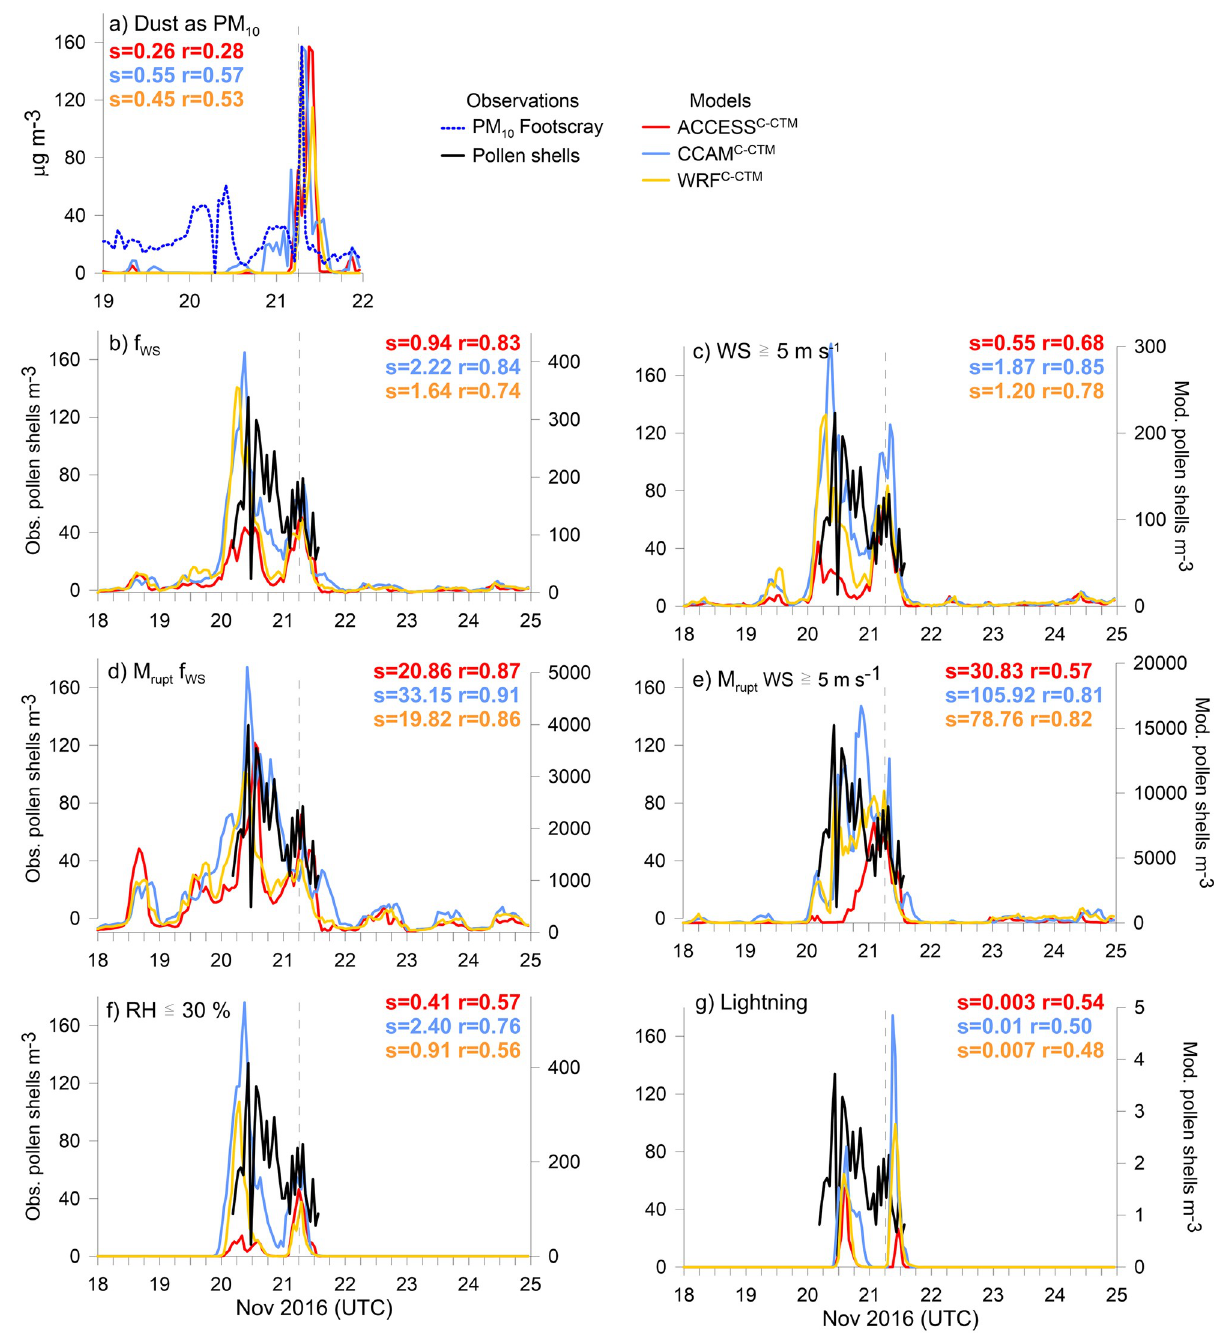
Fig 6. Time series at Melbourne in (a) dust as PM 10 , and (b-g) pollen shells for the seven labelled rupturing experiments. Note the modelled pollen shell concentrations are on the right-hand side y-axes in panels (b-g) and are not similar. s = slope of the linear regression and r = r correlations between modelled and observed pollen shells (or dust), given in same colours as the legend. Vertical dashed line indicates the time of the storm.